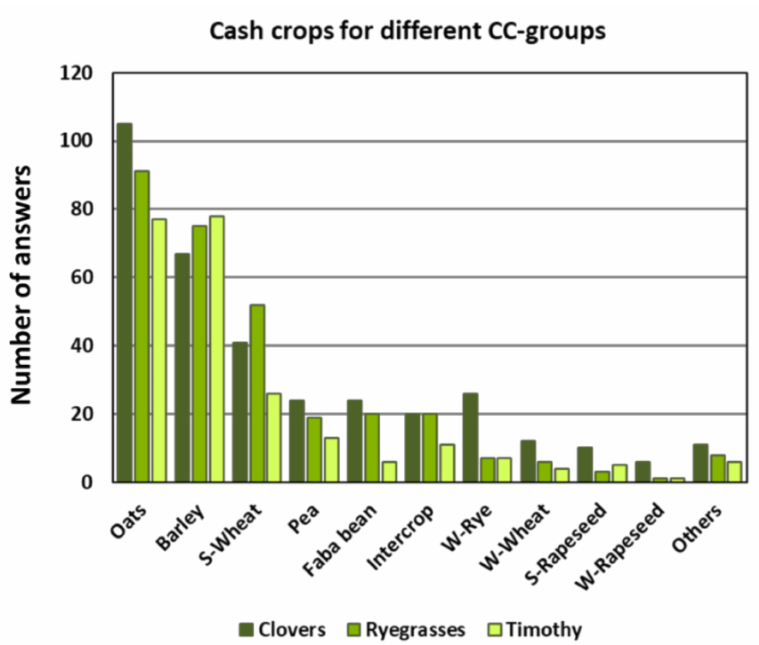
Figure 1. Cash crops for the most common under-sown cover crop (CC) groups in Finland: clovers ( n = 144), ryegrasses ( n = 132), and timothy ( n = 113). Letters S and W before a crop refer to spring and winter types, respectively, in the case the crop has both types grown in Finland. Intercrops contain cereals only.